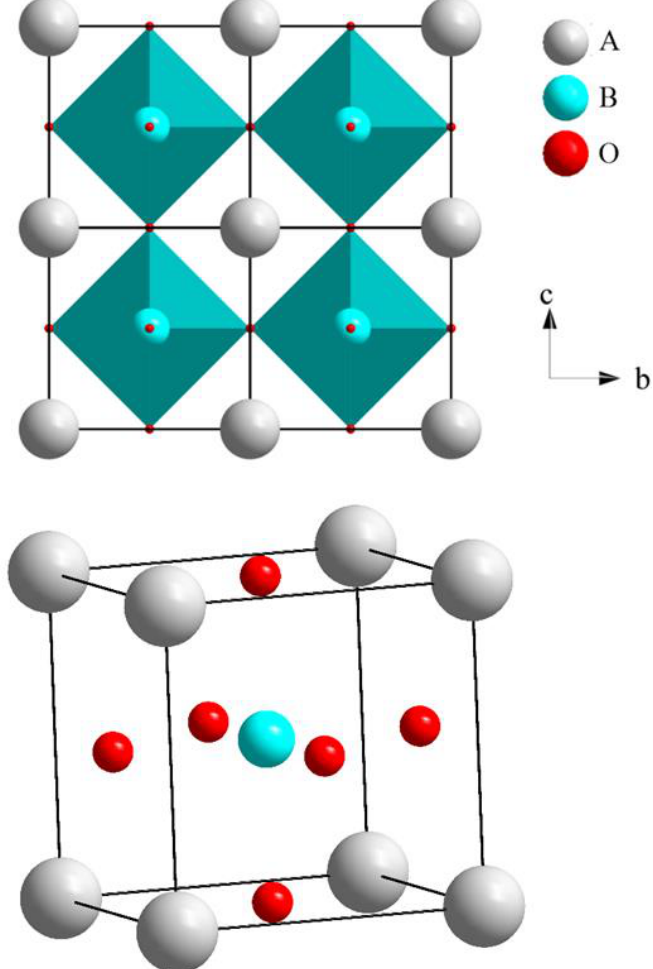
Figure 1 . The 2D and 3D view of ABO 3 -type cubic perovskites. Figure 1. The 2D and 3D view of ABO